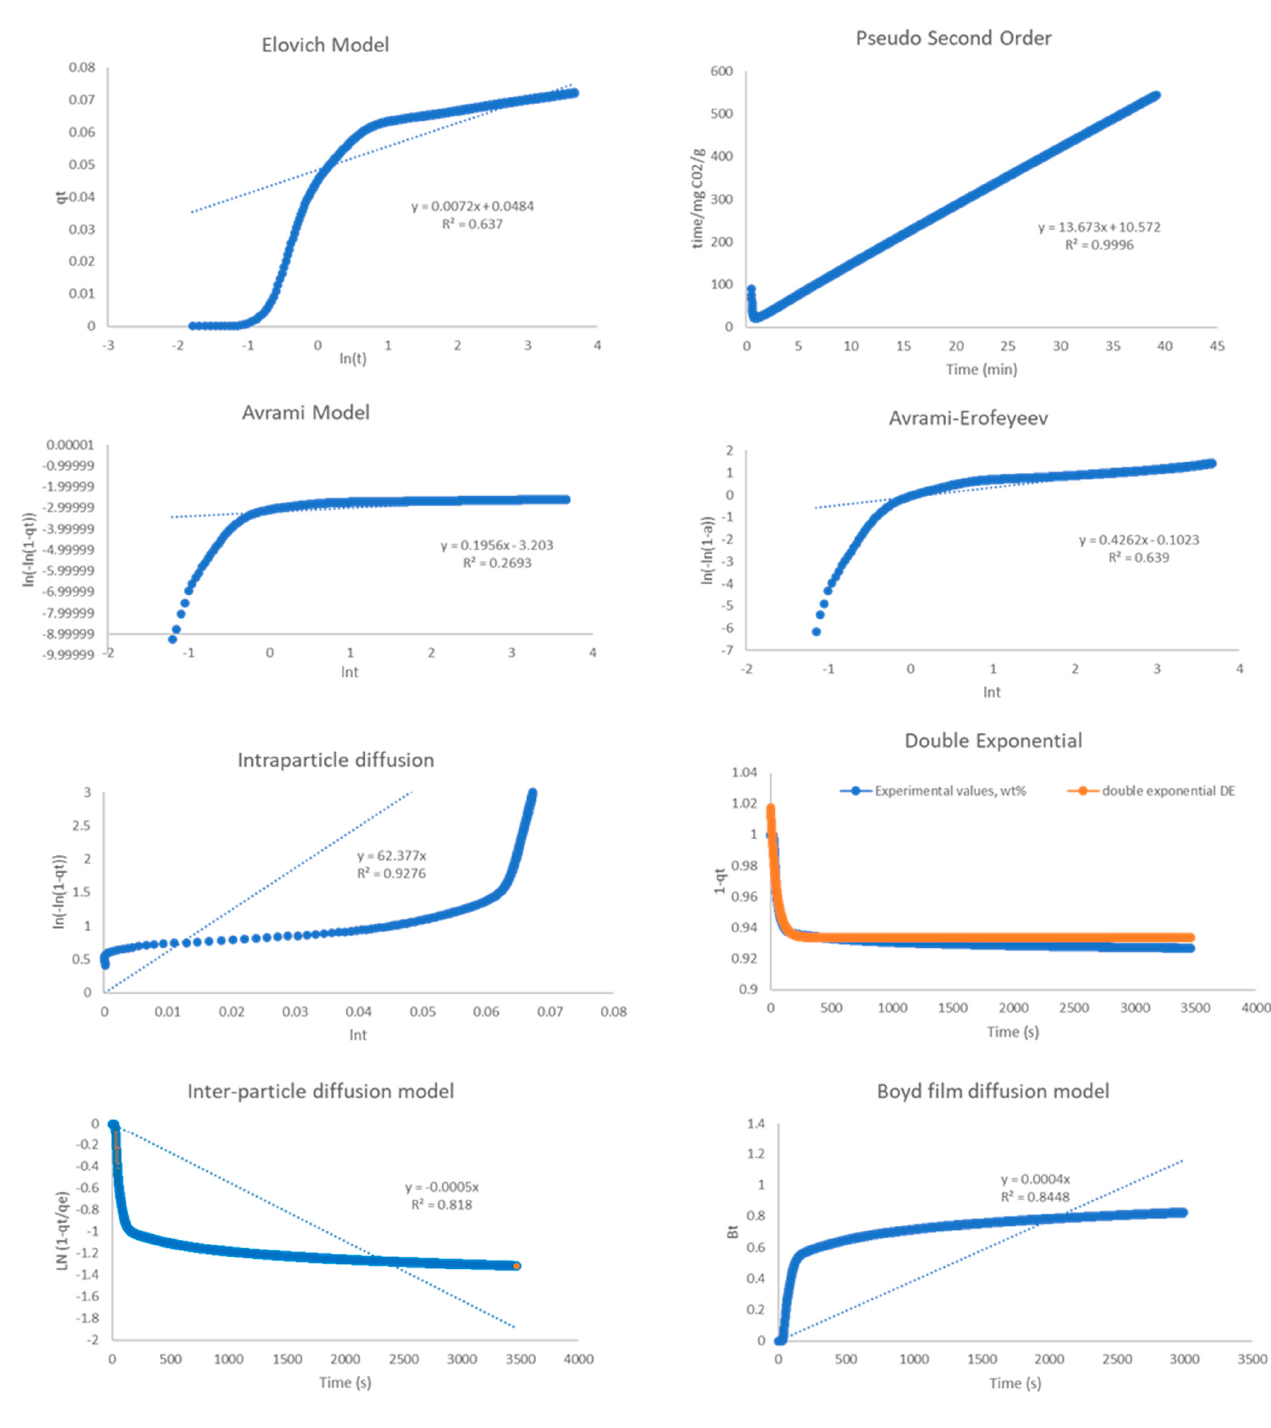
Figure A5. Kinetic modelling at 850 °C.